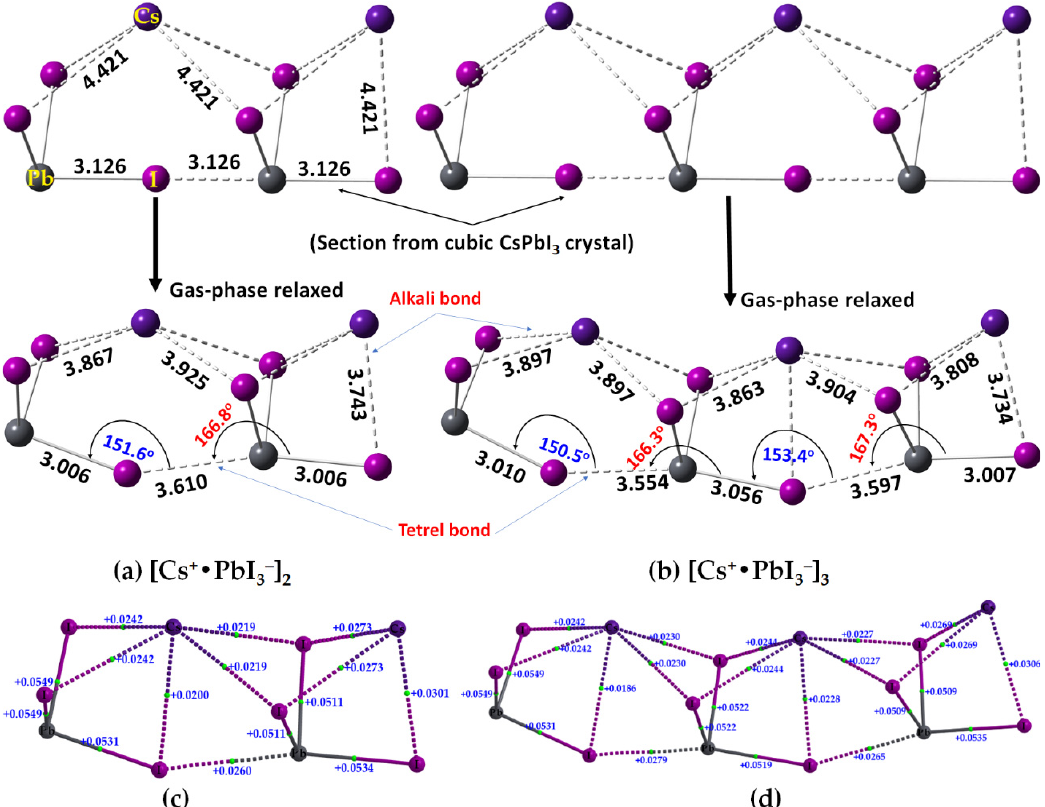
Figure 14. Illustration of sections from the cubic crystal of CsPbI 3 (top) and the [ ω B97XD/def2- TZVPPD]-level fully relaxed geometries (bottom) of ( a ) [Cs + • PbI 3 − ] 2 dimer and ( b ) [Cs + • PbI 3 − ] 3 trimer, showing selected bond distances and bond angles in Å and degree, respectively. Shown in ( c , d ) are the QTAIM molecular graphs, together with the Laplacian of the charge density at the bcps (a.u.) of the corresponding systems,